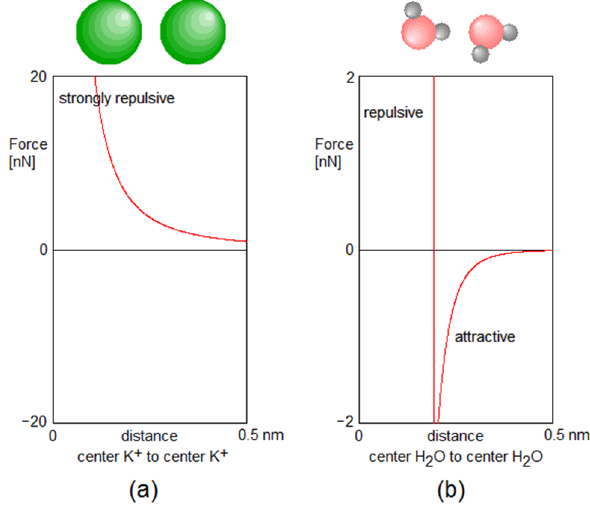
15 of 17 Figure A2. Force between a K + ion and the oxygen atom of a carbonyl group. As we modeled the oxygen atom as two-point charges, where one also carries mass (the actual O-atom), and the other no mass but only a charge (the center point of the lone pairs charge distribution) one must consider separately the force between the lone-pair electrons of the oxygen atom and the K + (picture (a)) and the force between the actual oxygen atom and the K + (picture (b)). ( a ): When the positive K + ap- proaches the negative electron lone-pairs point charge, there is a mutual attractive force due to the Coulomb interaction, which can reach almost 10 − 9 N. At a center-center distance of the two charges of 0.238 nm, however, the strong but constant repulsion of orbital overlap sets in, with a magnitude of about 1.7 × 10 − 9 N, which corresponds to an energetic cost of full overlap of K + and the electron lone-pairs charge density cloud of 100 k